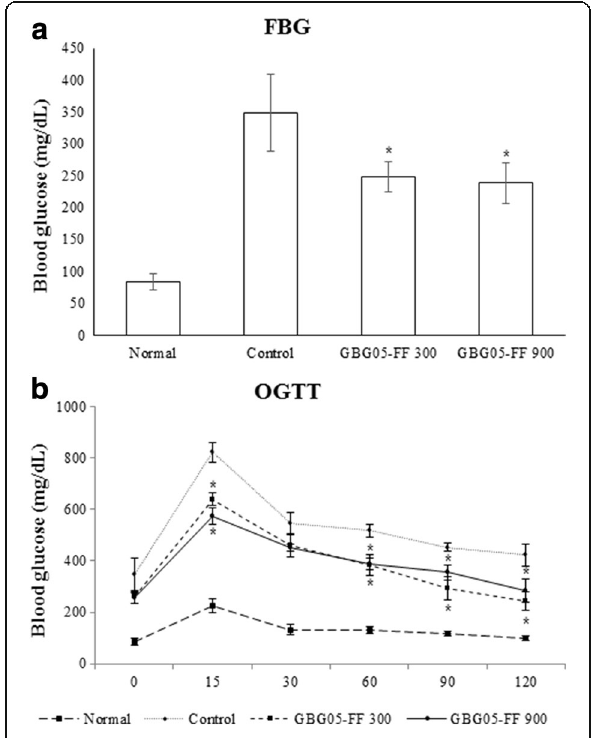
Fig. 2 Effect of GBG05-FF on fasting blood glucose levels ( a ) and glucose tolerance ( b ) in mice. Normal: dbh, Control: db/db, GBG05-FF 300: db/db fed the GBG05-FF 300 mg/kg, and GBG05-FF 900: db/db fed the GBG05-FF 900 mg/kg. Each value represents the mean ± SEM ( n = 10 per group). * P < 0.05: Significant difference vs. control group